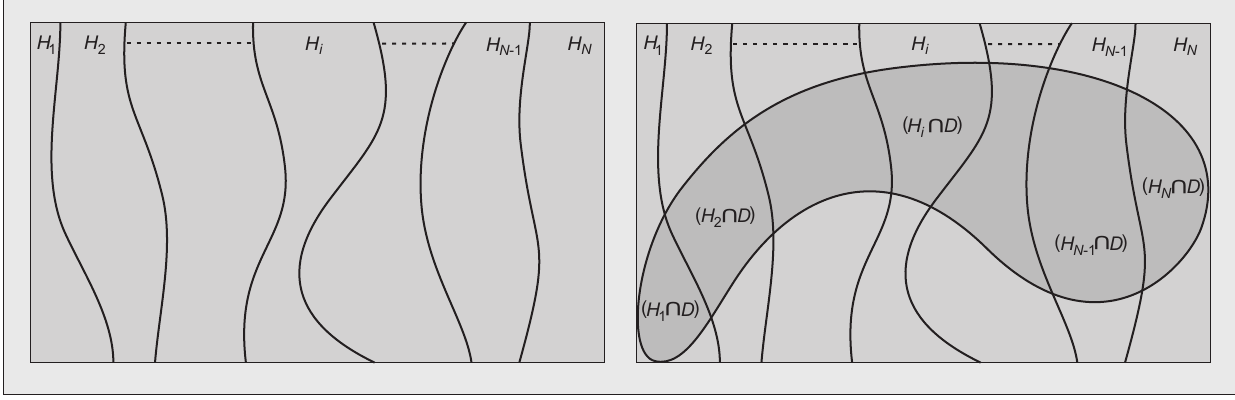
} (left); an event D in the i i